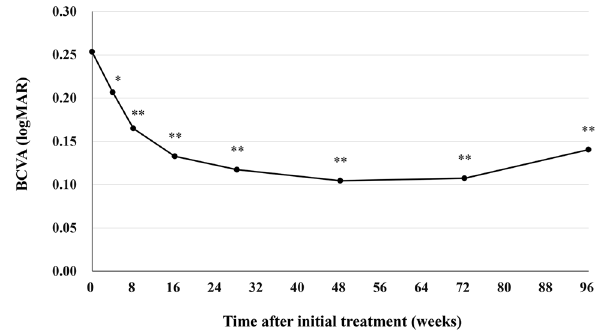
Figure 1. Change of average best-corrected visual acuity (BCVA) in 43 eyes with neovascular age-related macular degeneration associated with type 1 macular neovascularization treated with 3 monthly intravitreal injections of brolucizumab followed by a treat-and-extend regimen with intravitreal brolucizumab. The significant improvement of BCVA in the first year was maintained in the second year. (* P < 0.05, ** P < 0.01). Data are expressed as averages. Values at weeks 28, 48, 72, and 96 represent the averages of the values at weeks 24 and 28, 48 ± 4, 72 ± 4, and 84–96,